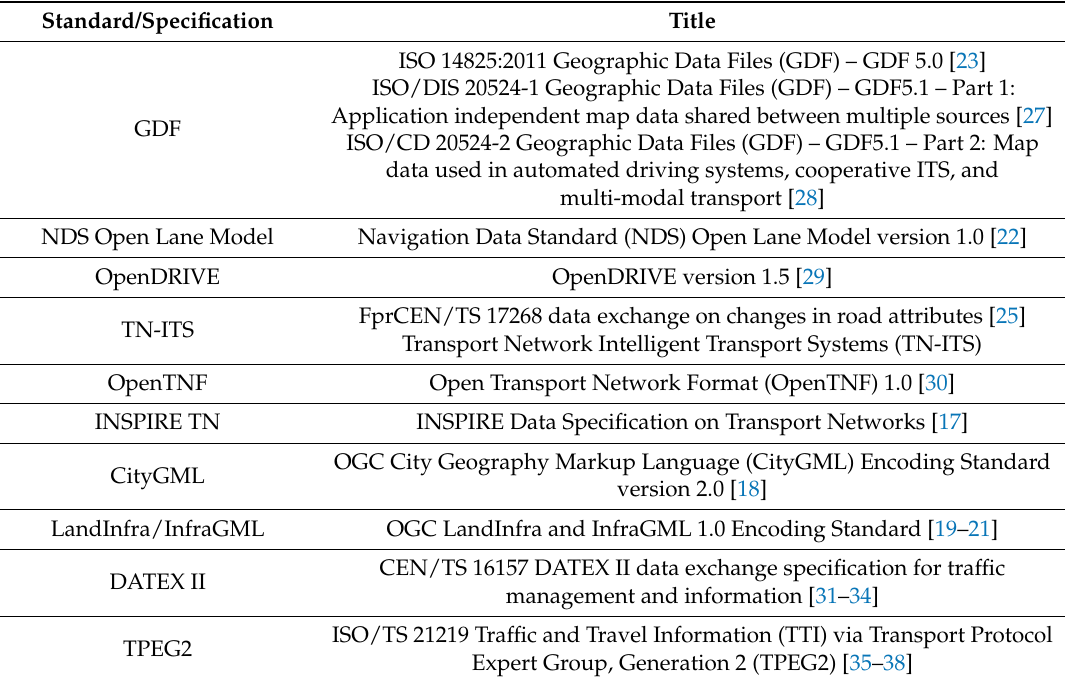
Table 1. Identified standards and specifications for geospatial road-related